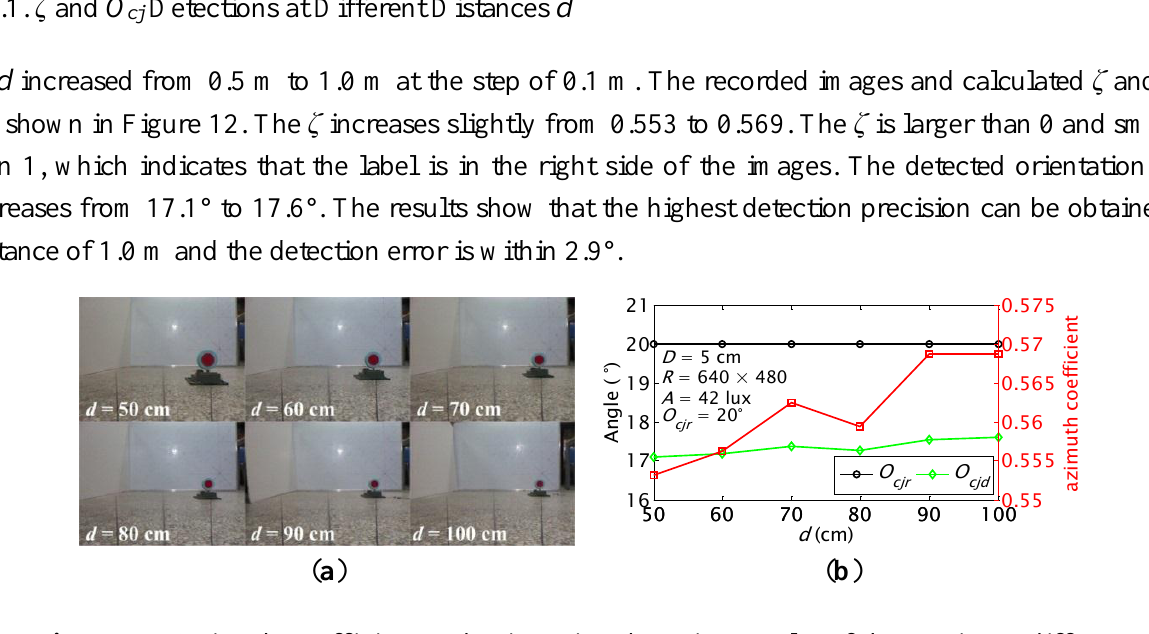
Figure 12. Azimuth coefficient and orientation detection results of the carrier at different distances when the real orientation O cjr is 20°: ( a ) recorded images; ( b ) calculated ζ and O cj .